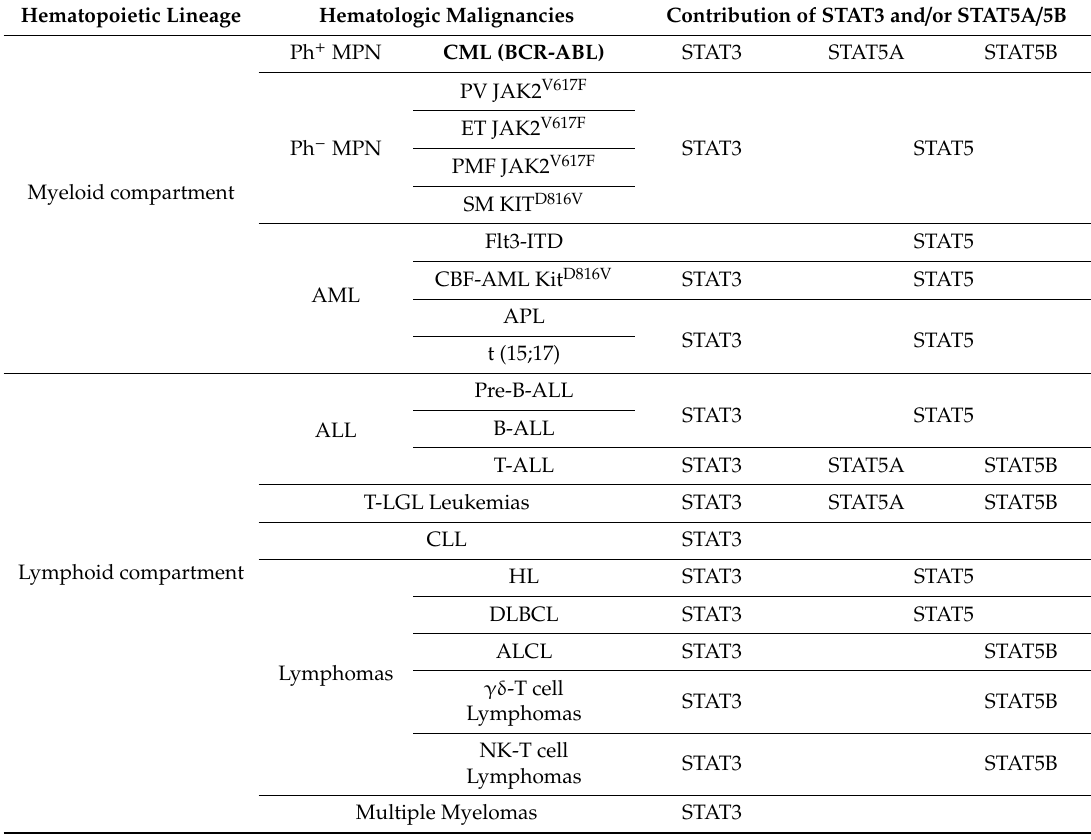
Table 1. STAT3 and STAT5 in hematologic